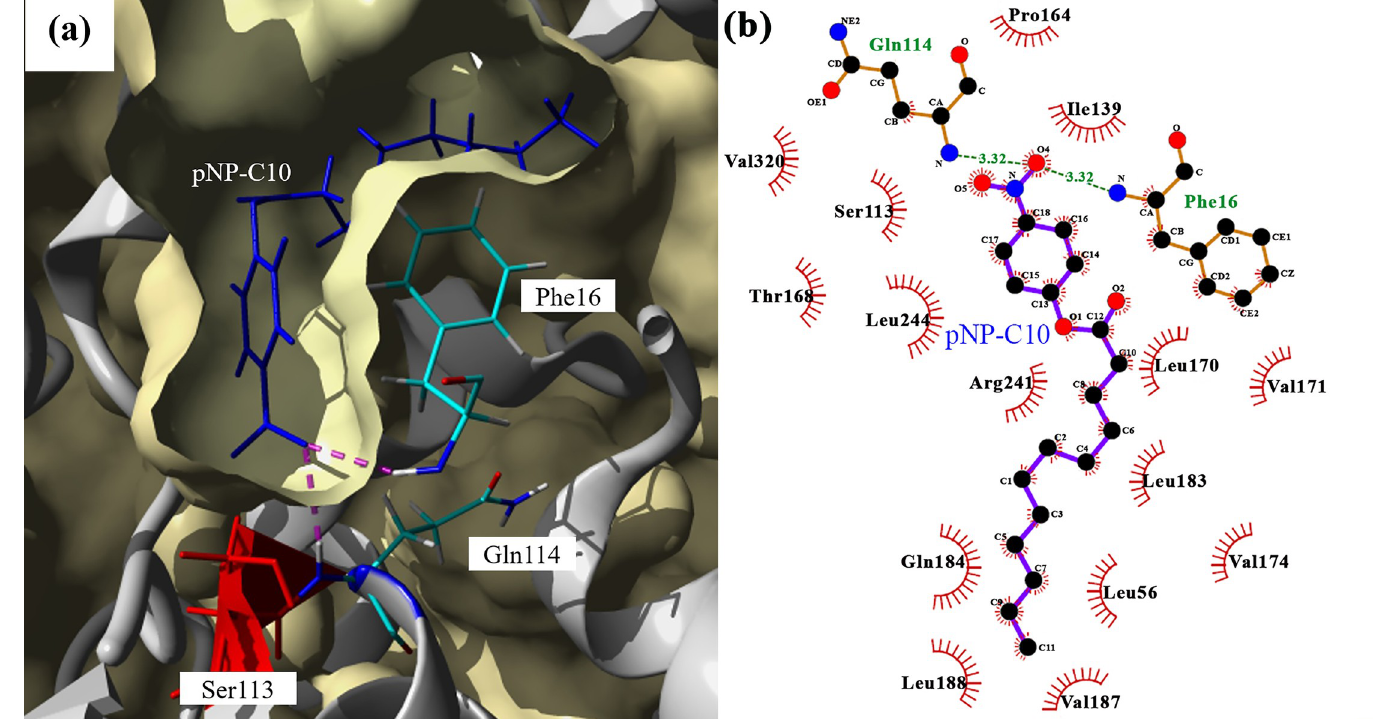
Fig 7. Molecular docking analysis of 5M lipase. (a) Molecular surface representation of 5M lipase with p NP-C10. Blue stick represents ligand. Oxyanion hole residues color in element. The red stick represents the catalytic residue, Ser113. Hydrogen bonds colored in magenta. (b) 2D interaction analysis of 5M lipase with p NP-C10. Hydrogen bonds are represented by a green dashed line, and hydrophobic interactions are represented by red spokes radiating towards the ligand. Ligands are represented in purple. C, N, and O atoms are represented in black, blue, and red, respectively. The images were generated via YASARA and LigPlot+ [27, 28].